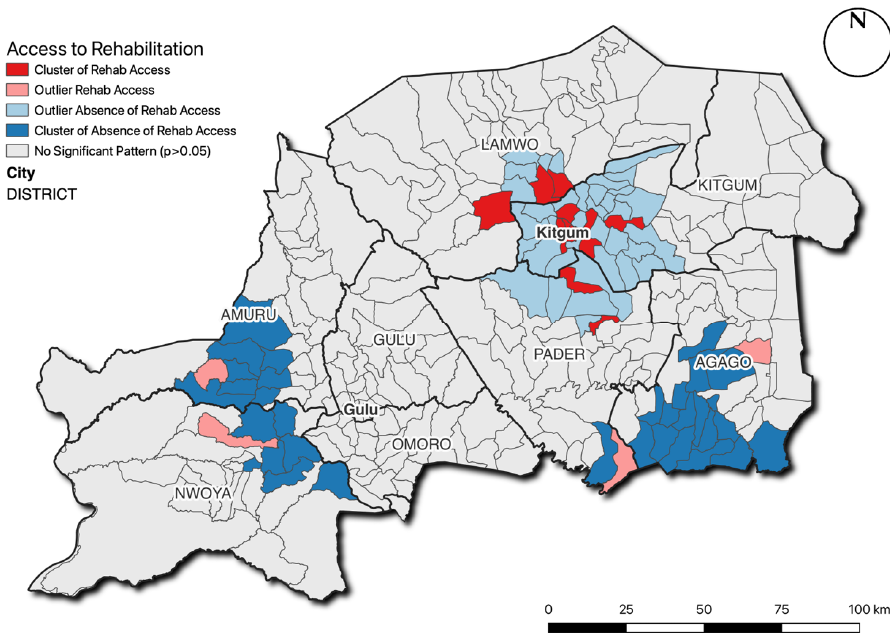
Figure 4. Map of clusters and outliers of people with MLL who have had access to rehabilitative services identified using the rate-adjusted Local Moran’s I (LISA) analysis. This clearly shows a significant cluster around Kitgum, which was the area of greatest activity from both the LRA and NGOs during the conflict.